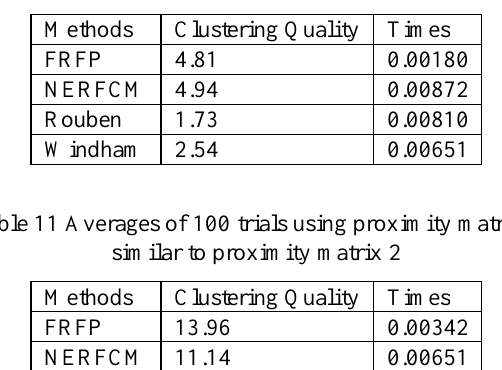
Table 10 Averages of 100 trials using proximity matrix 1 each time